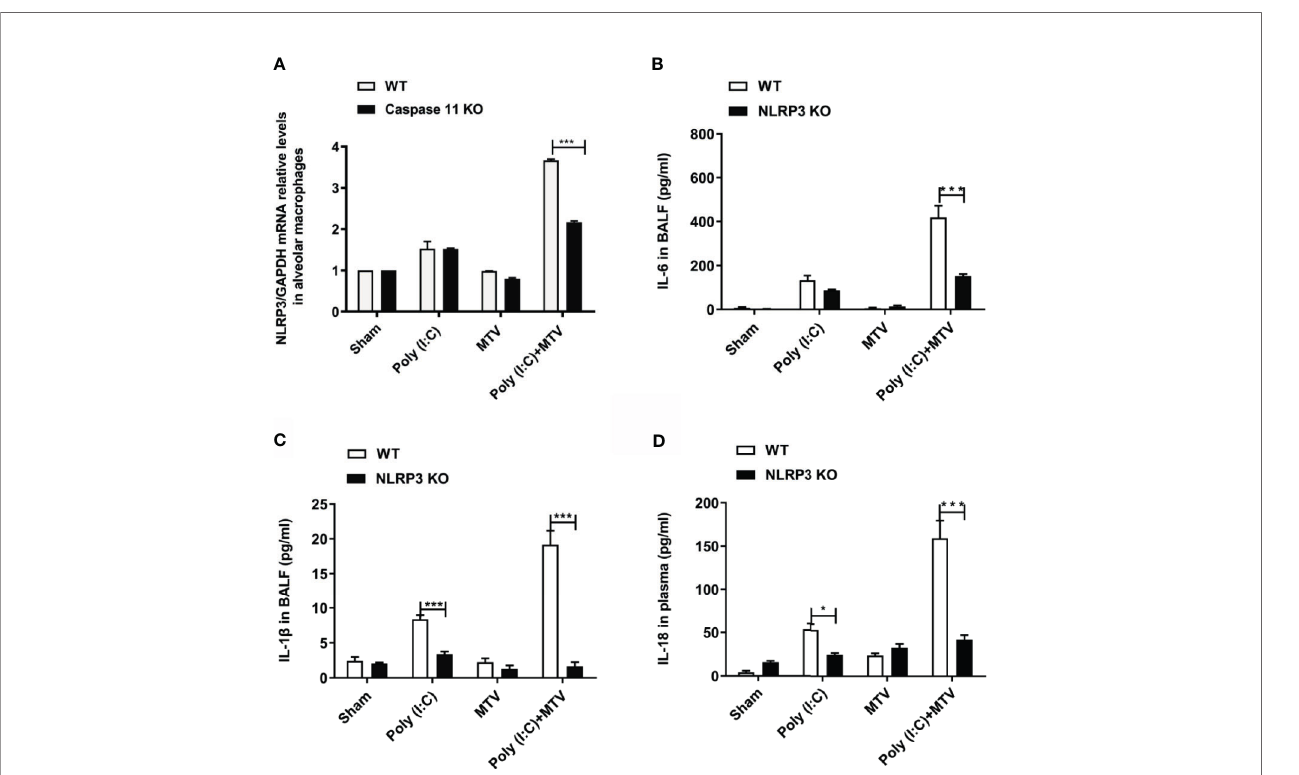
FIGURE 5 | NLRP3 was required for Poly(I:C)-MTV induced lung injury. Poly(I:C)-MTV increased NLRP3 mRNA levels in alveolar macrophages in WT mice but was partially inhibited by caspase-11 KO mice, (n=12) (A) . NLRP3 was required for Poly(I:C)-MTV induced IL-6 (B) , IL-1 b release in BALF (C) and IL-18 (D) secretion in plasma. In (B – D) , n=6 of each group for WT mice, n=8 for NLRP3 -/- mice. Results are shown as means ± SEM and compared by one-way ANOVA and Student- Newman-Keuls test. *** p < 0.001.